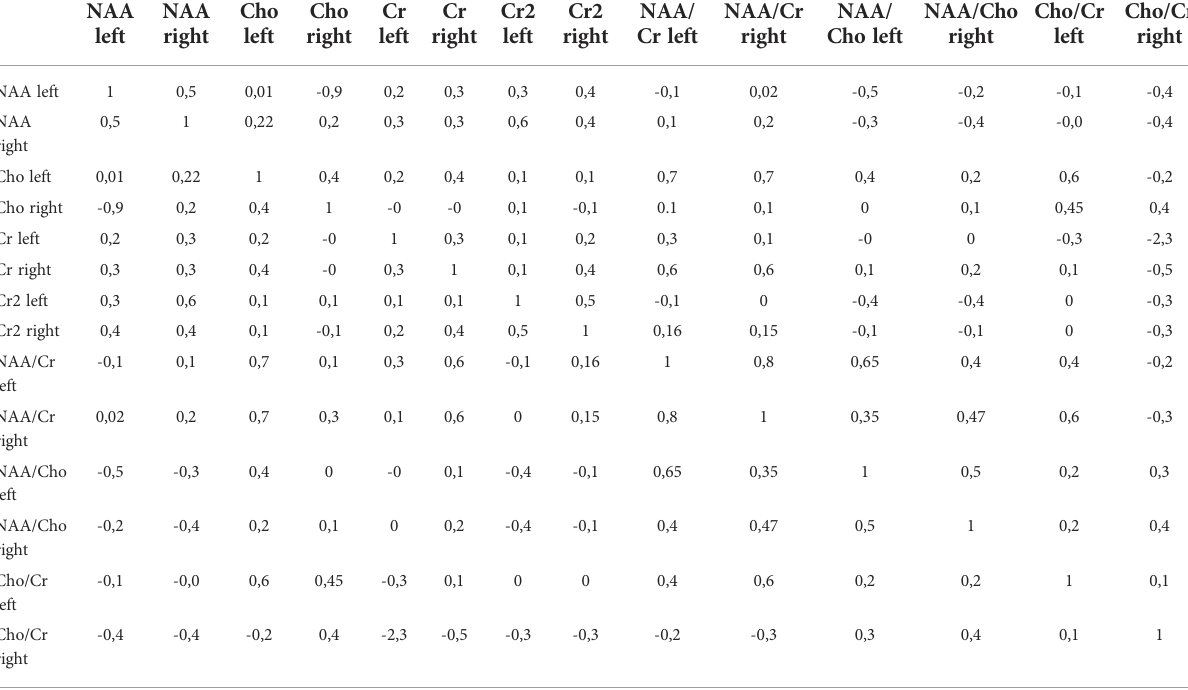
TABLE 5 Correlation matrix for checking the normality of parameters of proton spectroscopy of the brain.